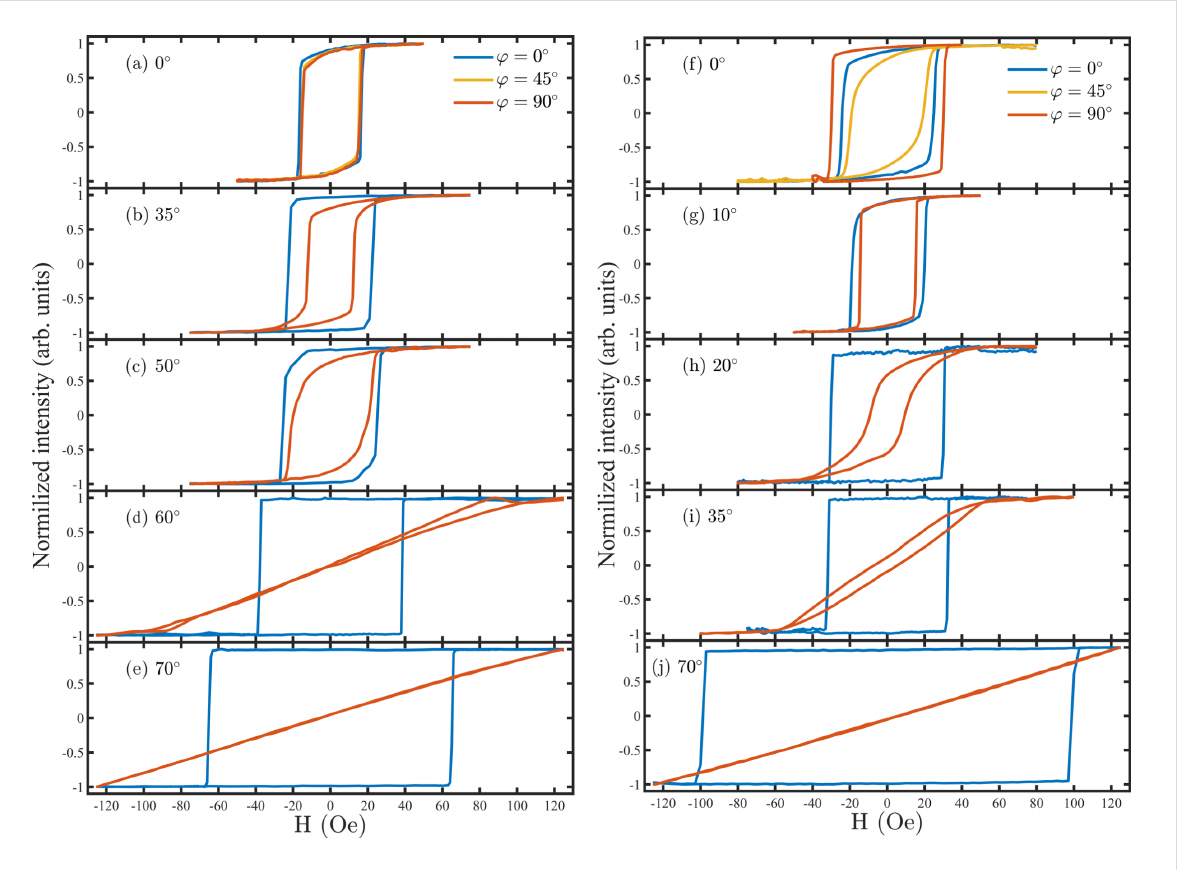
Figure 5: MOKE loops of nickel films that were deposited by (a–e) HiPIMS and (f–j) dcMS, at various tilt angles ranging from 0° to 70°, at 0.6 Pa working gas pressure, and 150 W average power. Each figure shows the in-plane angle of the applied magnetic field with respect to the incoming flux